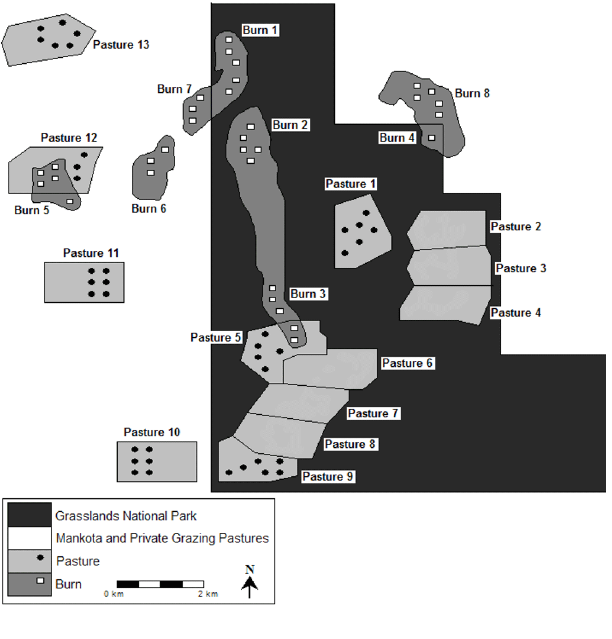
Fig. 2 . Study design to evaluate effects of burning and grazing on grassland songbirds in southern Saskatchewan, Canada, 2007 to 2011. Point-count plots (white squares: burned; black circles: unburned) were distributed across the study area in clusters. Unburned-ungrazed clusters (pastures 1, 5, and 9) and burned-ungrazed clusters (burns 1-4) were in the East Block of Grasslands National Park. Most of the unburned-grazed clusters (pastures 10-13) and burned-grazed clusters (burns 5-7) were in the Mankota Community Pastures. One burned-grazed point-count cluster (burn 8) was in a private, grazed pasture. Pastures 2-4 and 6-8 were not used for our study as their grazing regimes varied over